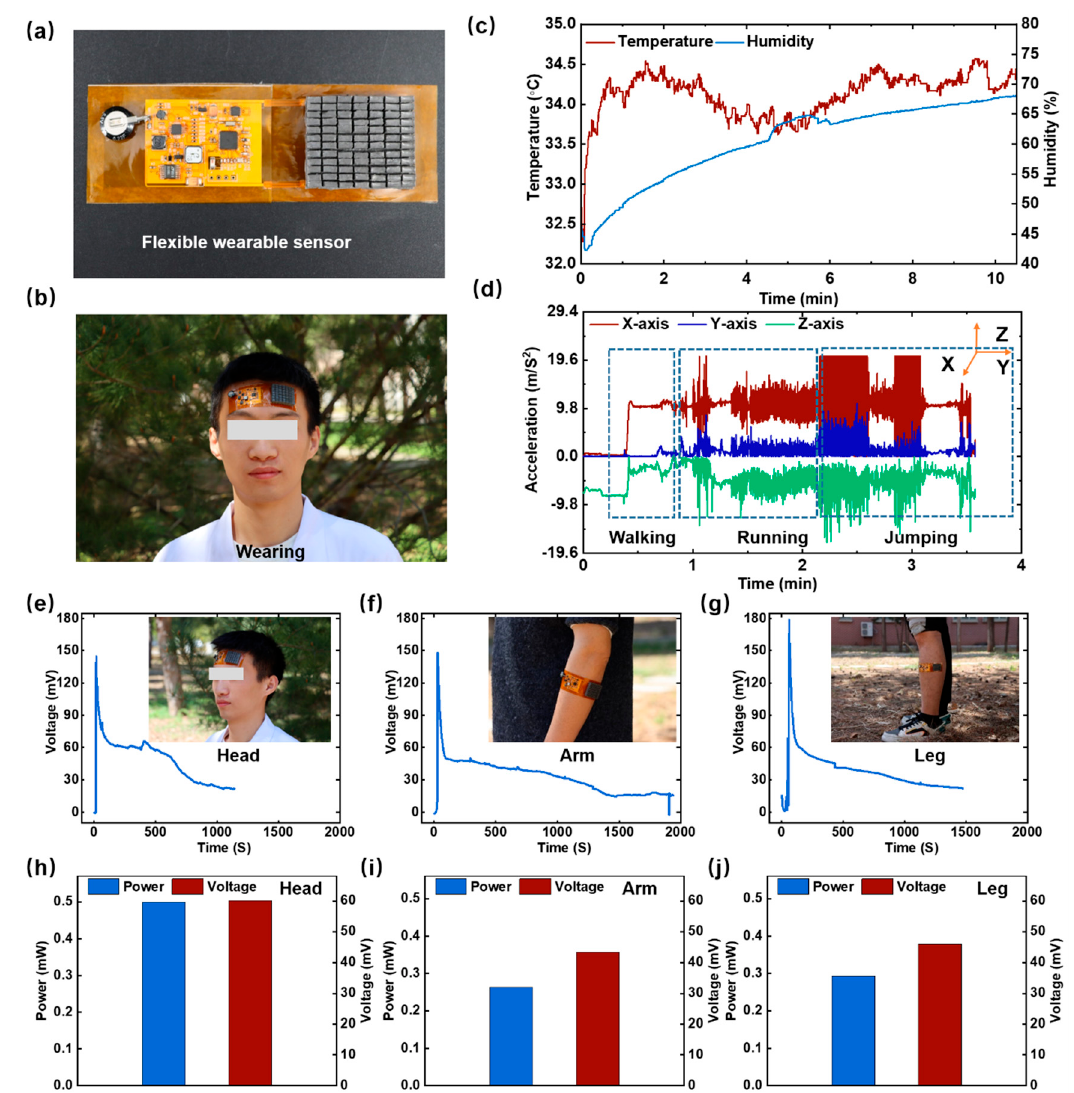
Figure 6. The application of LM-WTEG-powered wearable sensors: ( a ) photos of the wearable sensors powered by LM-WTEG and ( b ) it is worn on the forehead; ( c ) human temperature and humidity data and ( d ) micro accelerometer data; ( e–j ) average output power and open voltage of LM-WTEG when it is worn on the forehead, arm, and leg.